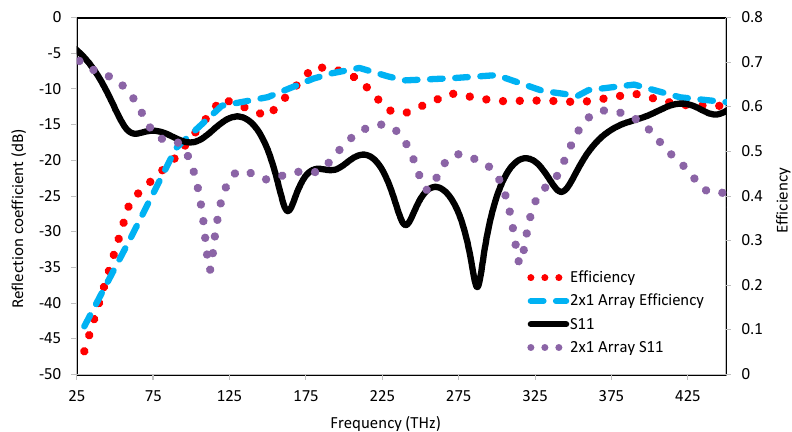
Figure 14. Performance comparison for various spacings between the elements in the 2 × 1 array design.